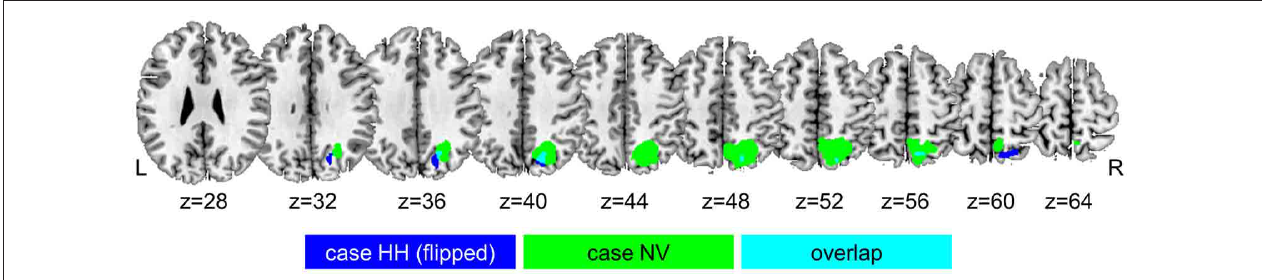
FIGURE 3 | Overlap between the right-sided middle IPS lesion in case NV (in green) and the left-sided posterior IPS lesion in case HH (in blue), after flipping the lesion of case HH from the left to the right hemisphere.